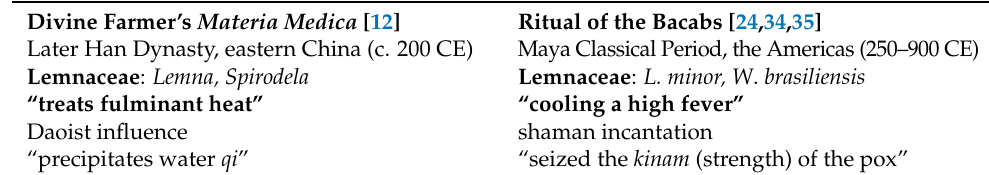
Table 6. Ethnobotanical convergence suggested in ancient duckweed medicinal